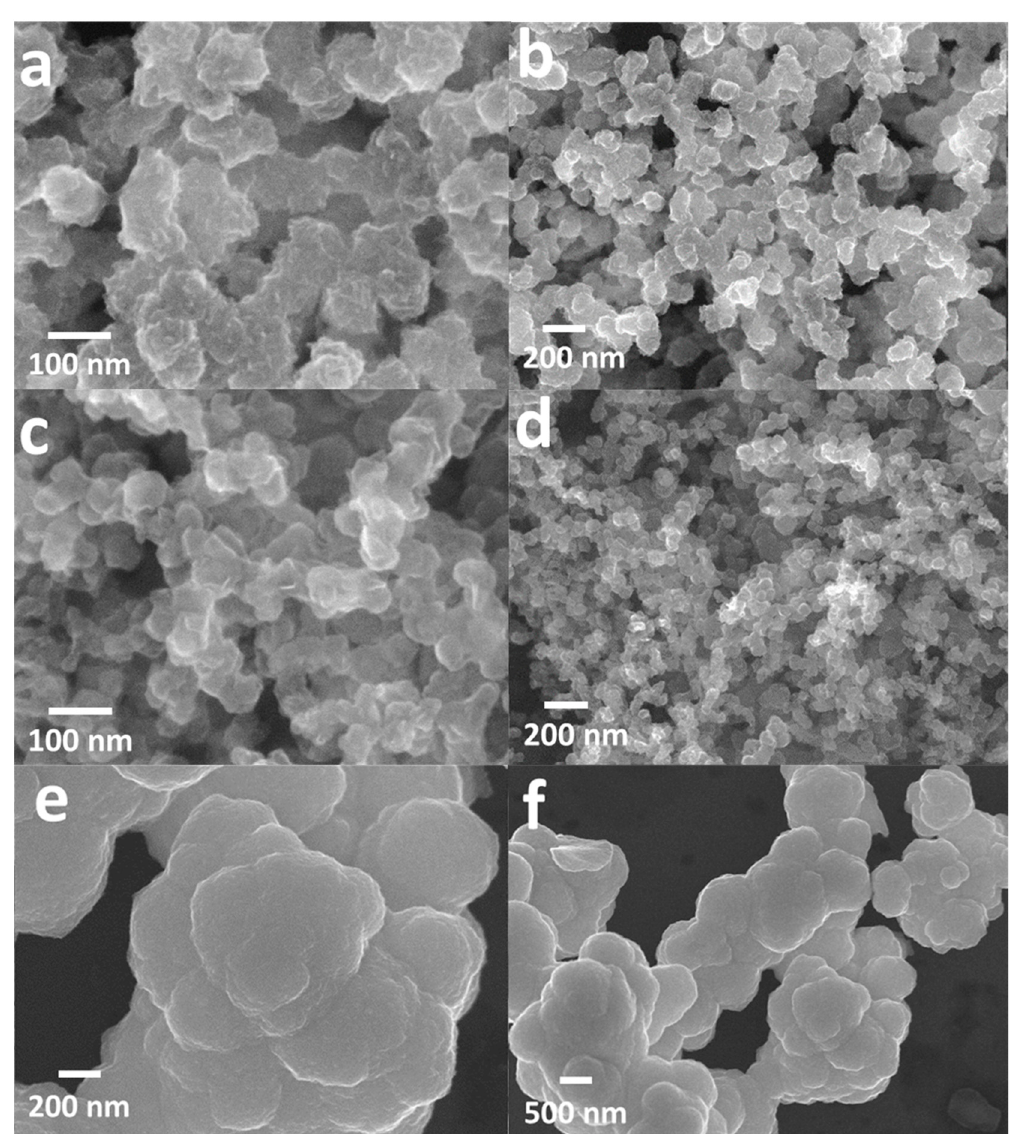
Figure 2. SEM images of the ( a , b ) ReS 2 @CB, ( c , d ) pure CB and ( e , f ) ReS 2 powder